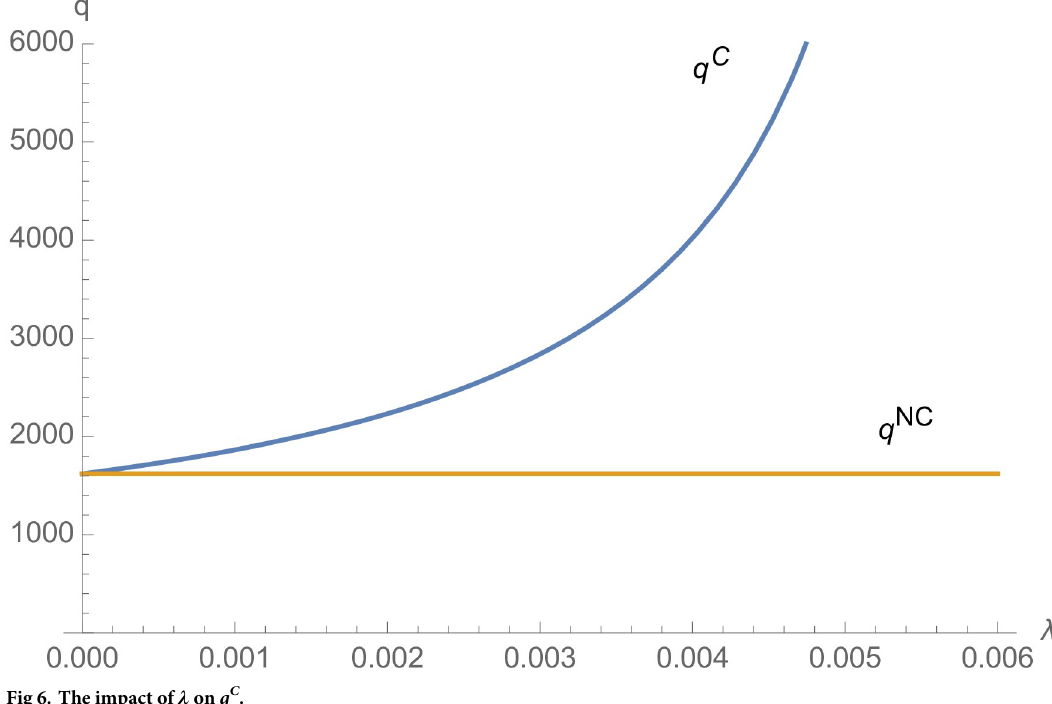
Fig 6. The impact of λ on q C .